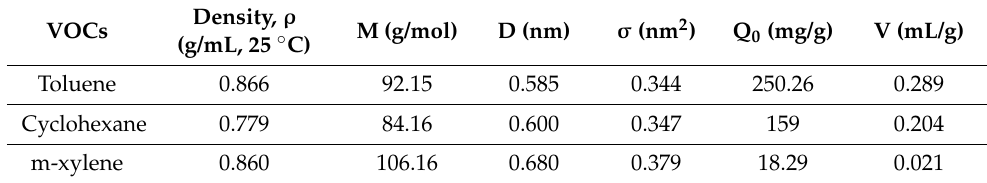
Table 4 lists the following properties of the VOCs studied: density, kinetic diameter (D), molecular cross-sectional area ( σ ), quantity of VOC adsorbed on the MOF (Q 0 ) and adsorption capacity in volume (V). Table 4. Properties of selected VOCs.